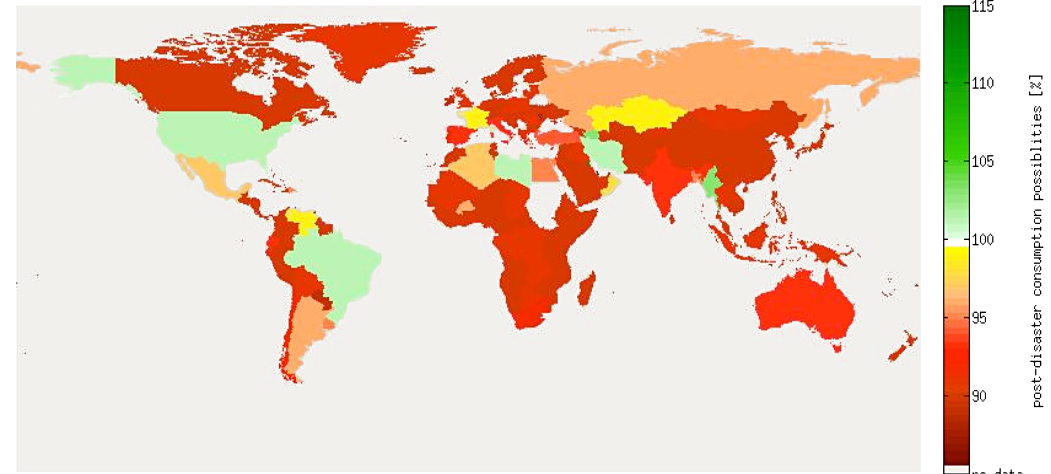
Figure 5. In scenario 3, an Australasian storm, the effects, again, are seen most strongly in the directly impacted countries and their trade